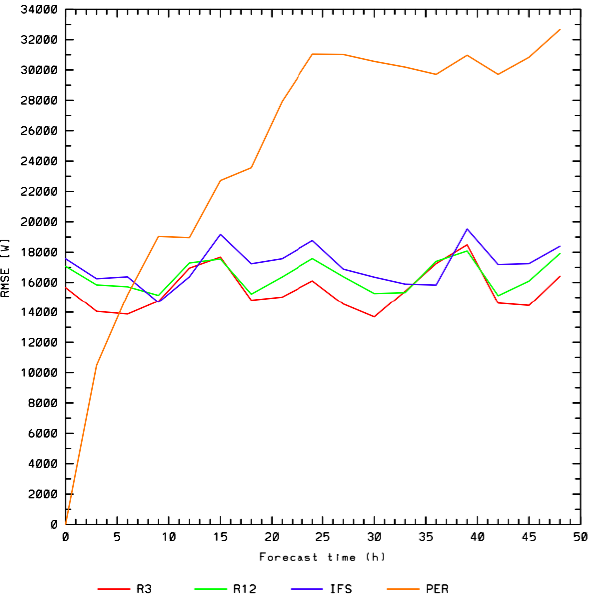
Figure 6. RMSE for R3 (red), R12 (green), IFS (blue) and PER (orange) as a function of the forecasting time for the first and second forecast